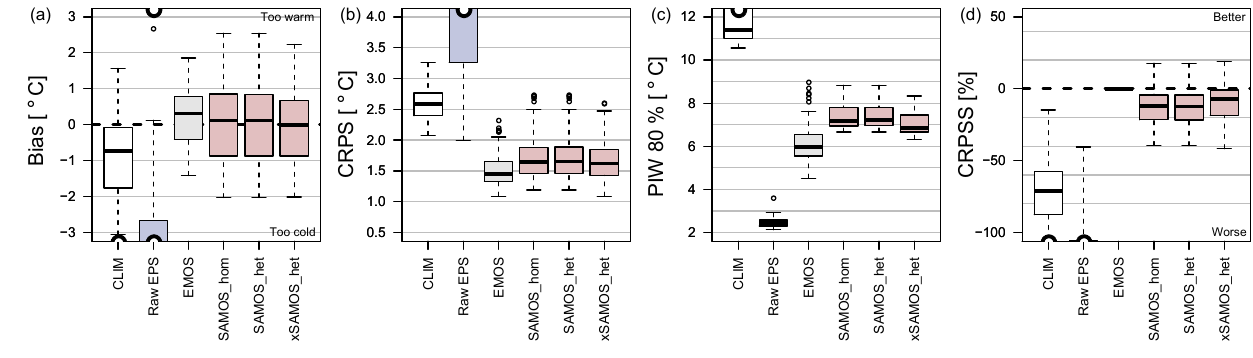
Figure 2. Scores for 2m temperature forecasts based on the full predictive distribution based on 6 / + 12 /.../ + 72 / + 78h forecasts as used for model training. The box-and-whisker shows station-wise means for (a) bias (observation minus forecast), (b) CRPS, (c) width of the 80% prediction interval, and (d) CRPS skill scores with EMOS as reference. Scores are shown for the climatology (CLIM), the raw EPS, and the four postprocessing models (cf. Table 1). Abscissa are set to manually specified ranges; the “semi-sphere” marker (top/bottom) indicates data outside the plotted range.